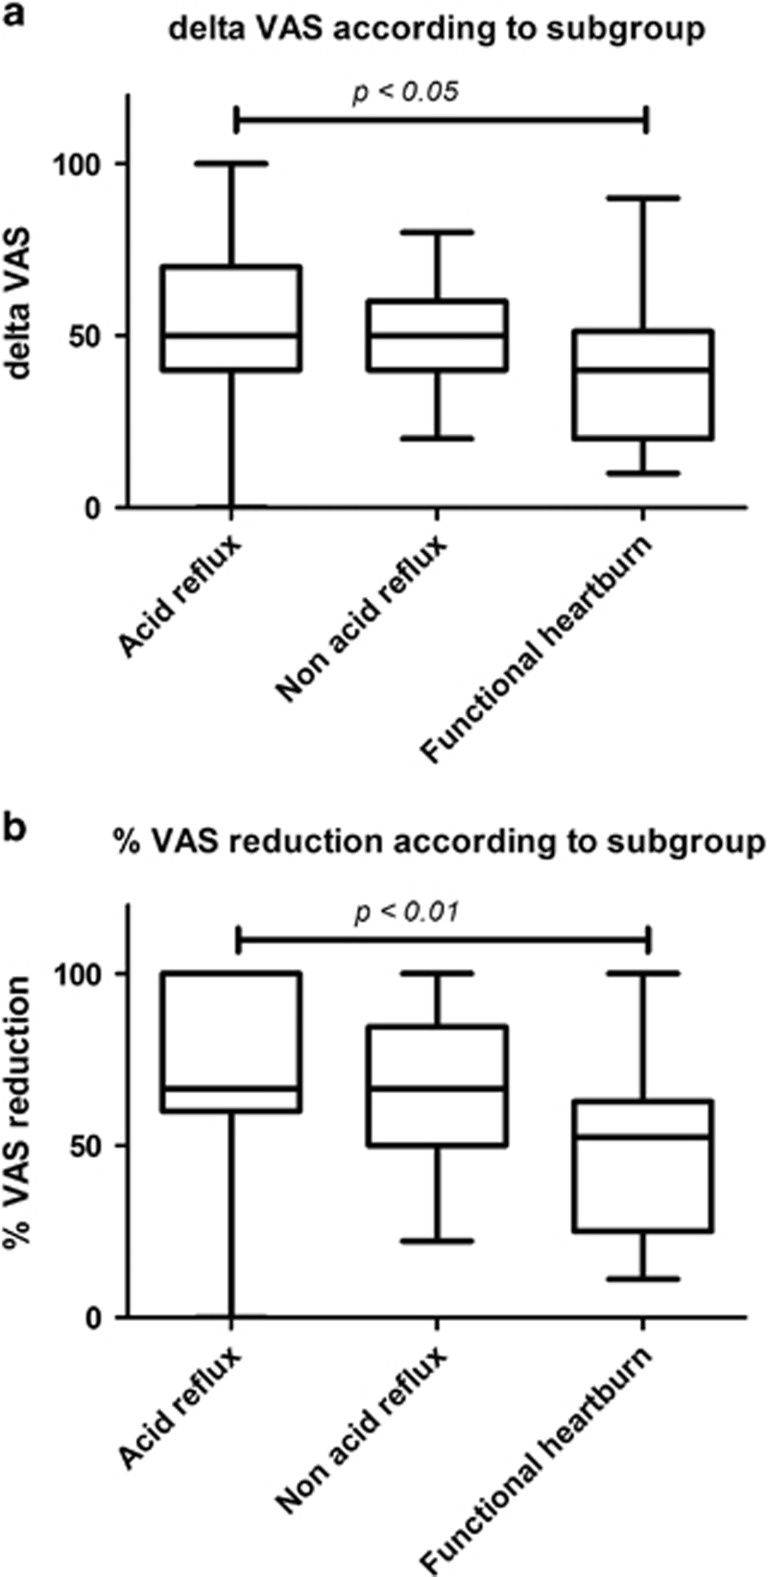
In (a), mean delta VAS for each subgroup patients (acid, non-acid reflux and functional heartburn) are illustrated and compared by Kruskal–Wallis test with Dunn’s post hoc analysis. In (b), percent variations VAS for each subgroup patients are reported and compared by Kruskal–Wallis test with Dunn’s post hoc analysis. *P<0.05; **P<0.01. The figure reports boxplots, summarizing median, interquartile range, minimum and maximum